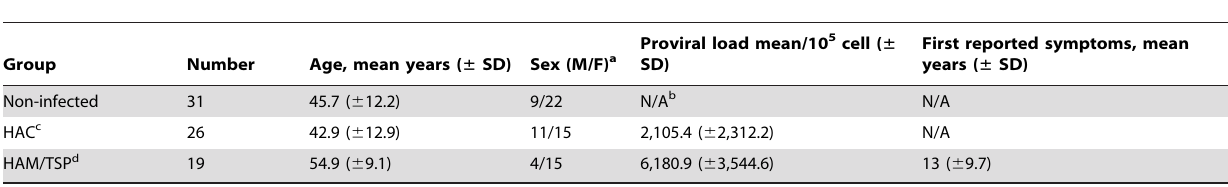
Table 1. Demographical and Clinical Characteristics of the Study Groups.